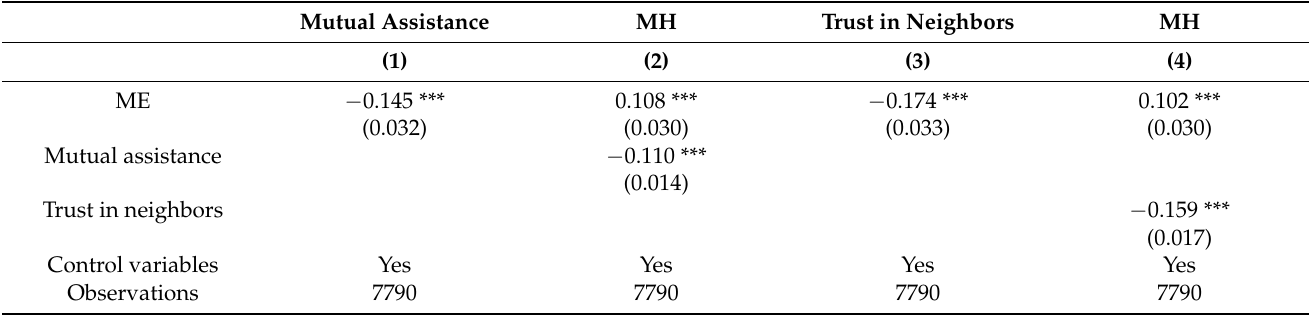
Table 6. Mechanism analysis: social